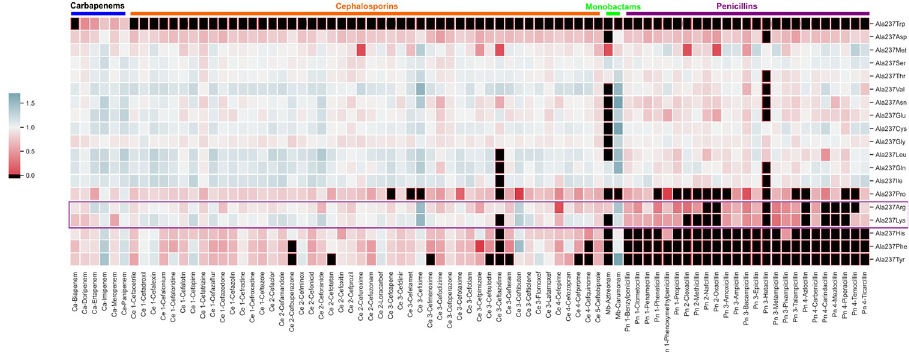
Fig 2. Clustered heatmaps of relative docking scores for each docked compound against TEM β -lactamase structures harboring mutations in active site residue alanine 237. Black indicates that the docking algorithm could not find poses that bind in realistic conformations to the target due to overwhelmingly unfavorable interactions that lead to nonphysical energies, such as steric clashes introduced by the aromatic substitutions. Docking scores are normalized with respect to the wild type docking score of each